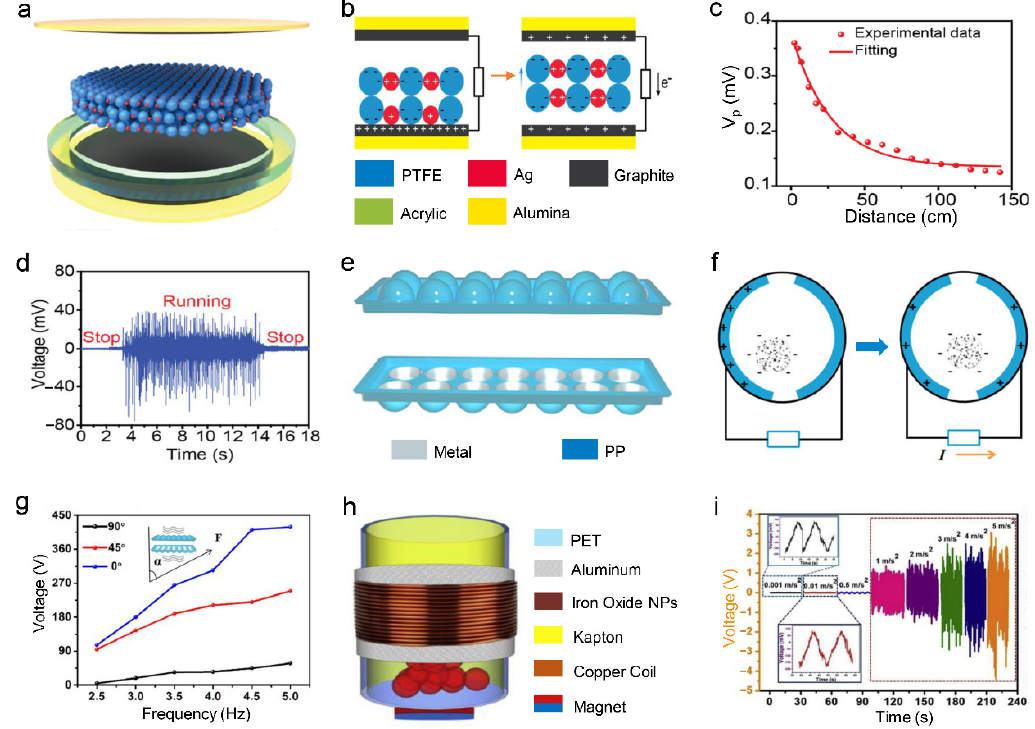
Figure 6. The point contact vibration sensor. ( a ) Structural design of the HVS. ( b ) Schematic showing the full cycle of the electricity generation process of the HVS. ( c ) Attenuation results with increased distance. ( d ) The output voltage waveform of HVS after the engine starts and stops. Reproduced with permission [127]. Copyright 2021, Elsevier. ( e ) Structural design of the S-TENG. ( f ) Schematic diagram of the working principle of the S-TENG. ( g ) The open-circuit voltage working at different vibration angles. Reproduced with permission [128]. Copyright 2021, Elsevier. ( h ) Schematic structure of the MP-HG. ( i ) The relation curve between electrical signal output of MP-HG device and different acceleration. Reproduced with permission [129]. Copyright 2019,